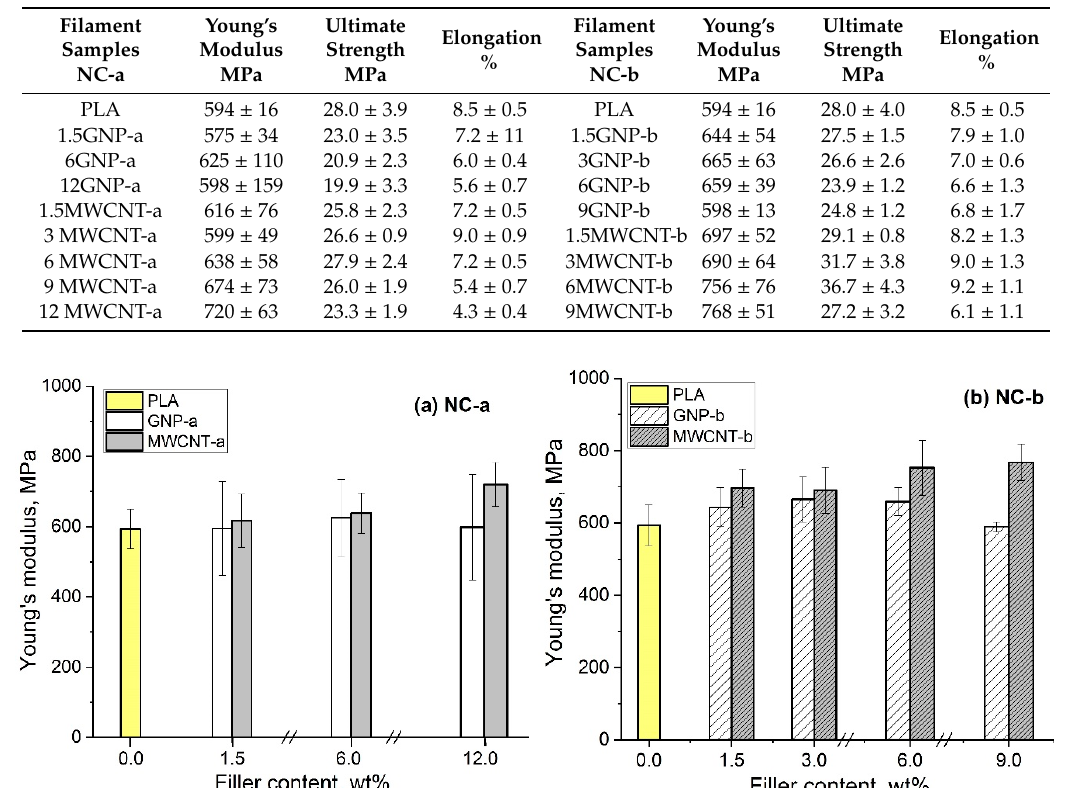
Figure 6. Young’s modulus vs. filler content of the neat PLA and nanocomposites with varying filler content. Comparison of nanocomposite series: ( a ) NC-a with GNP-a, MWCNT-a; and ( b ) NC-b with GNP-b, MWCNT-b.